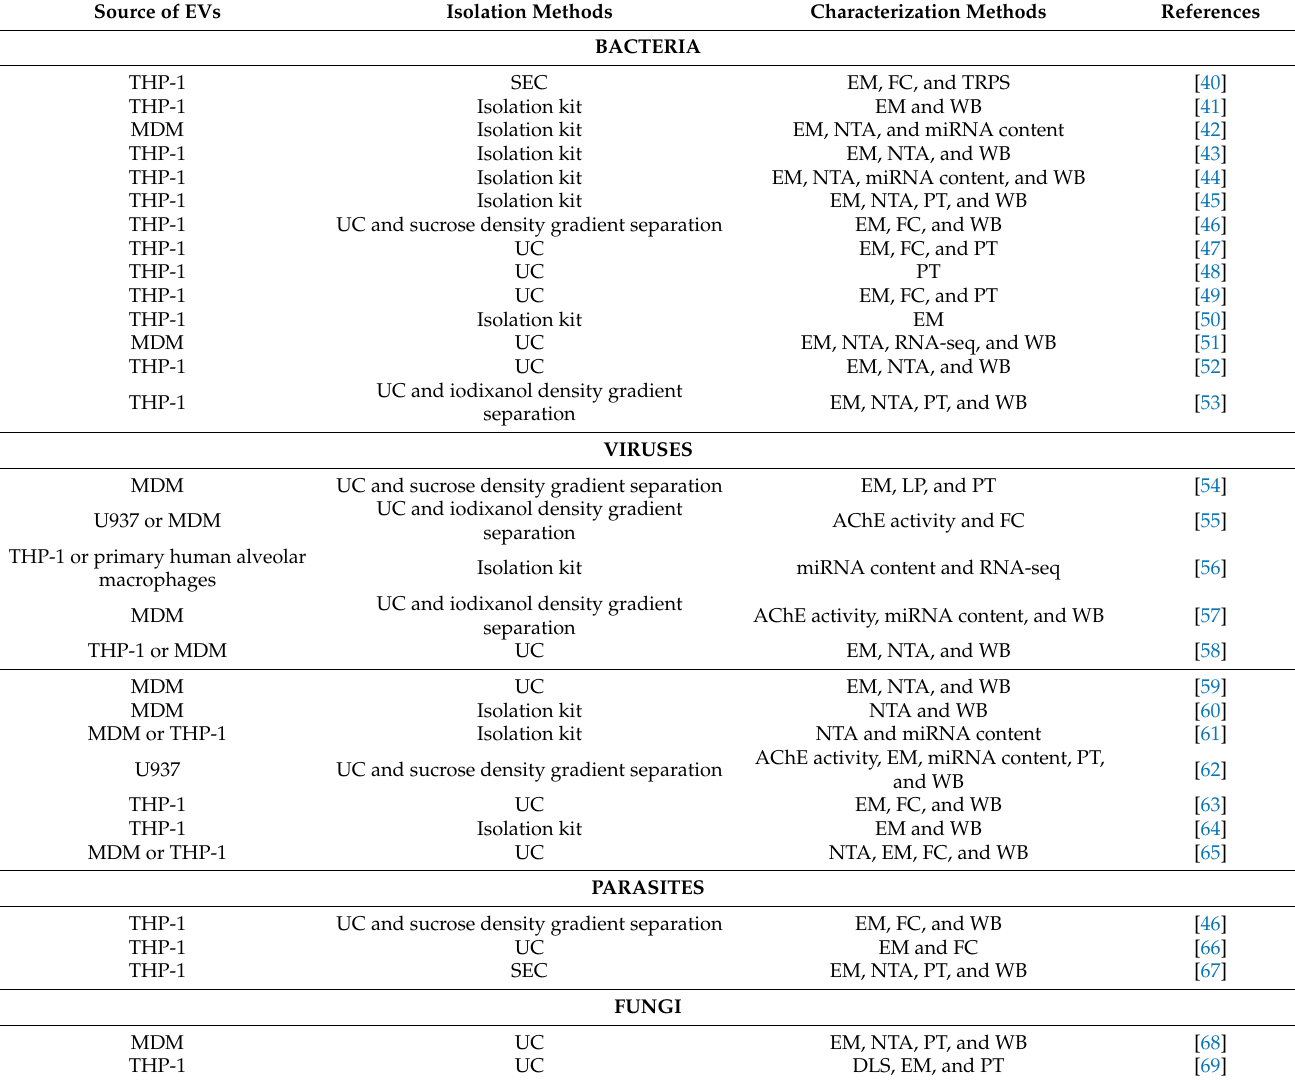
Table 2. Methods applied to separate and characterize EVs from human